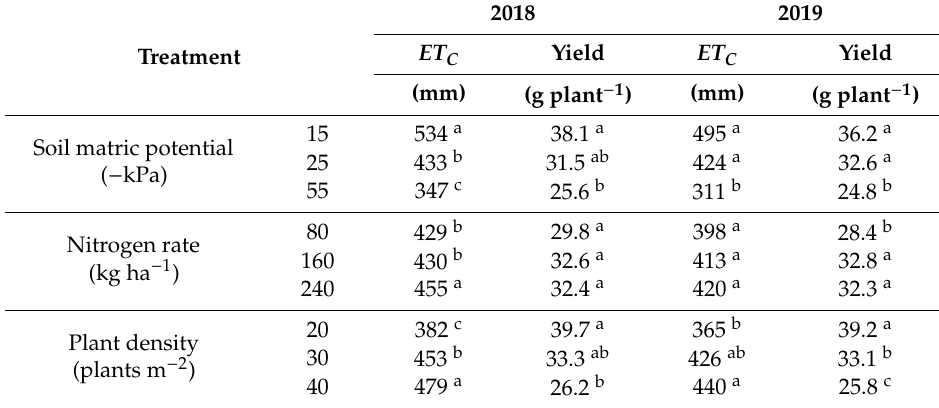
Table 3. E ff ects of soil matric potential, nitrogen application rate, and plant density on quinoa crop evapotranspiration ( ET C ), and yield during the 2018 and 2019 growing seasons.